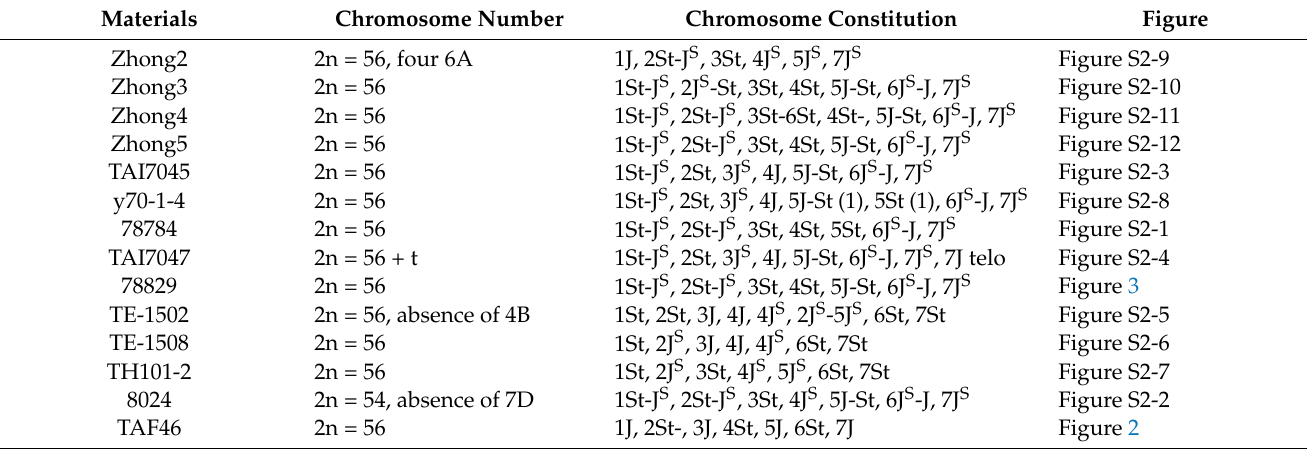
Table 1. The Thinopyrum chromosome constitution of the wheat– Th. intermedium partial amphiploids.